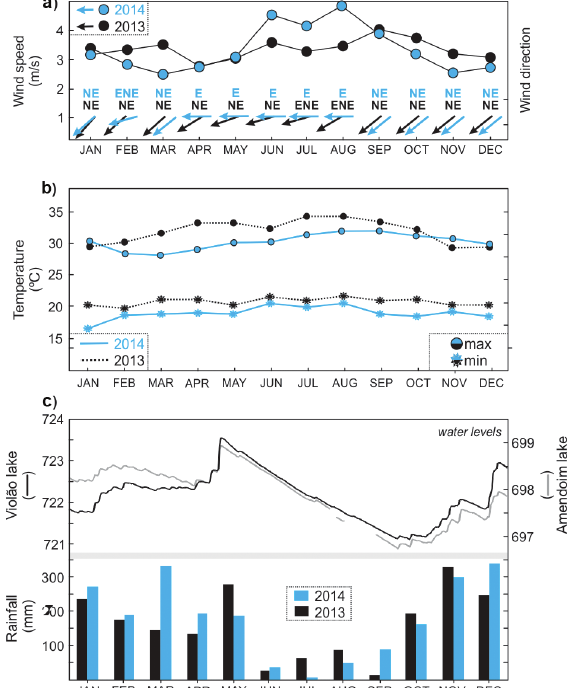
Figure 2 - a) Wind intensity and direction at the S11D station during 2013; b) maximum and minimum air temperature (ºC) at the S11D station (left corner) and rainfall (right corner, dashed line) data at the S11D station during 2013 (lower corner), and 30yr-median rainfall of wettest months (Feb- Mar-Apr; square symbols) and driest months (Sep-Oct-Nov, rhombuses symbols) at the Marabá Station (upper corner); c) Water level changes in Violão (left corner) and Amendoim (right corner) lakes during 2013.